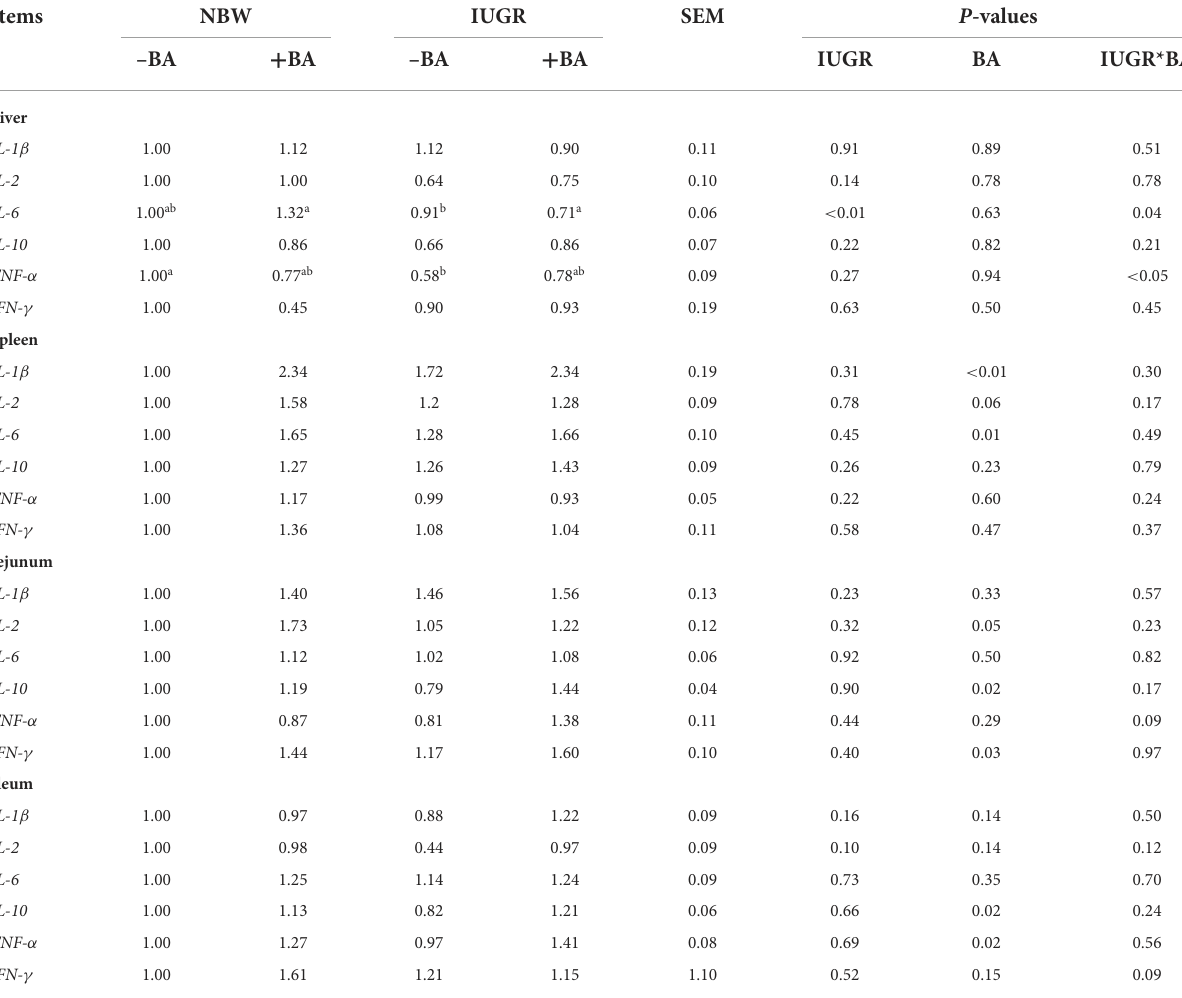
TABLE 4 Effects of dietary bile acid (BA) supplementation on the intestinal and liver cytokines expressions in weaned piglets with NBW and